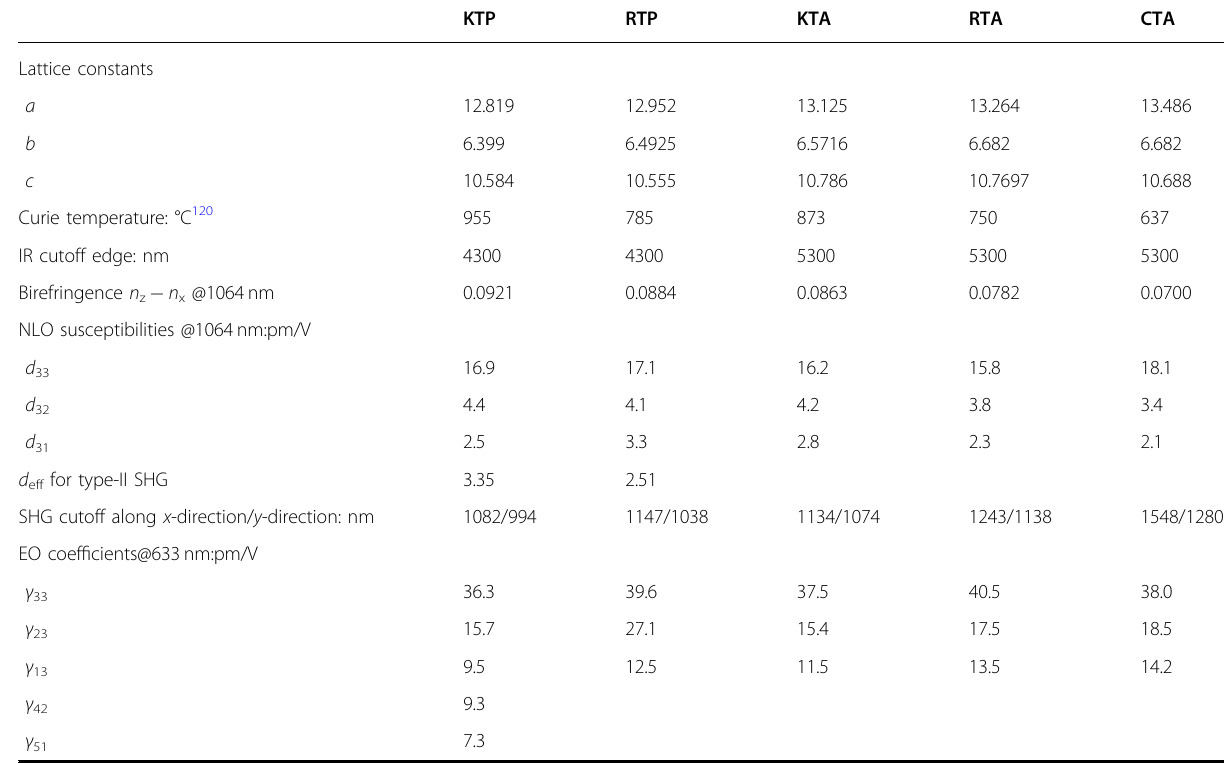
Table 2 Crystal lattice parameters and selected physical properties of KTP and isomorphs, the most data are from the synthesis of literatures